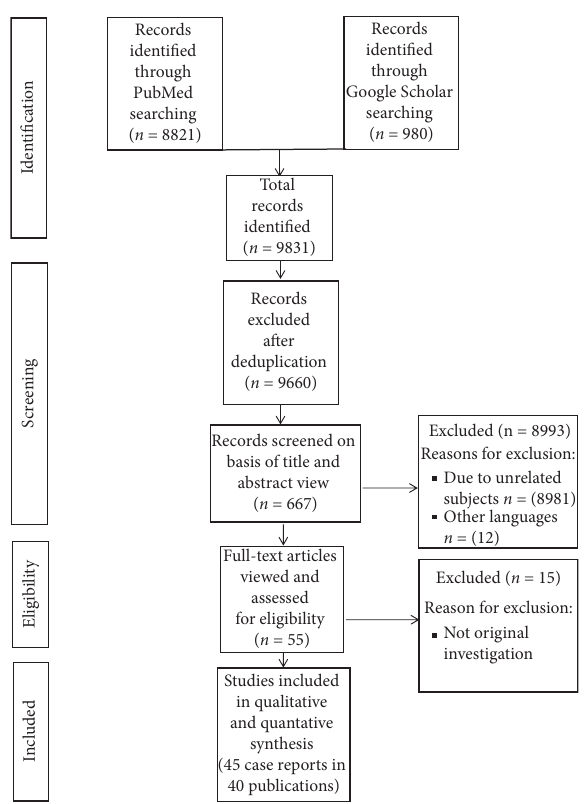
Figure 1: Workflow for identification of clinical studies of thyroid and kidney